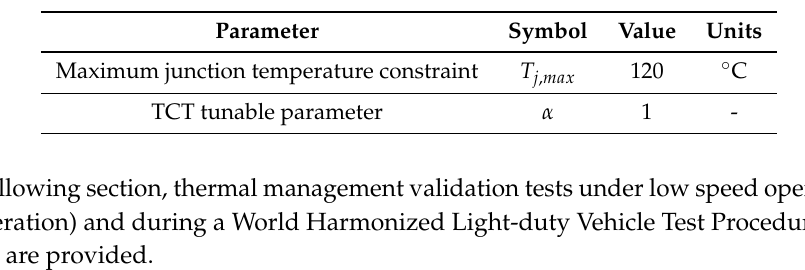
Table 3. Regulation parameters of the Temperature Constraint Tracking (TCT)